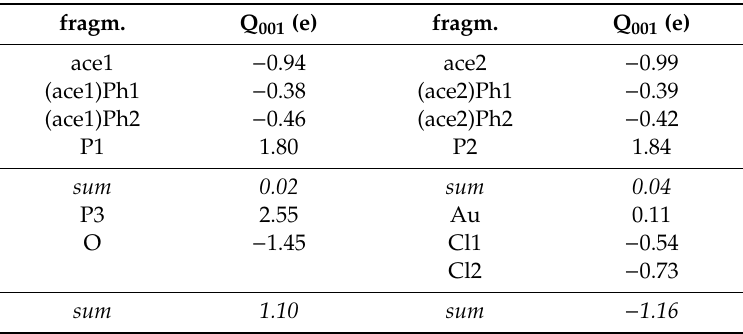
Table 3. AIM atomic and fragmental